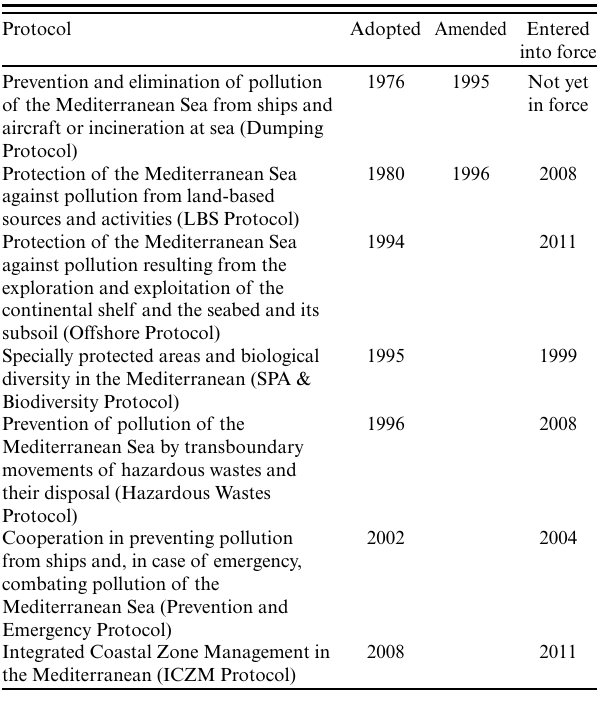
Table 2. Seven protocols addressing specific aspects of Mediterranean environmental conservation (UNEP-MAP